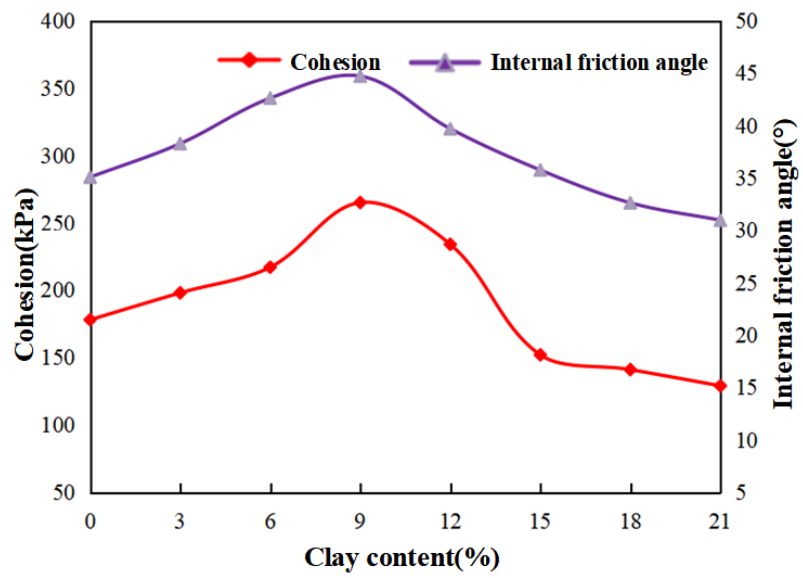
Figure 9. Cohesion and internal friction angle with different clay contents (MICP-Treat).